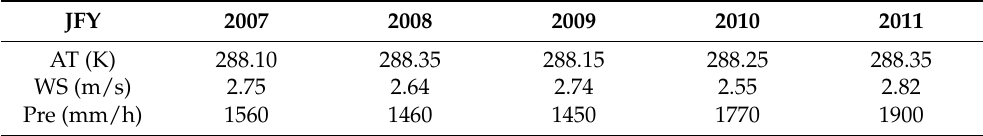
Table 1. Annual average measured data for air temperature (AT), wind speed (WS), and precipitation (Pre) at Hikone (observation